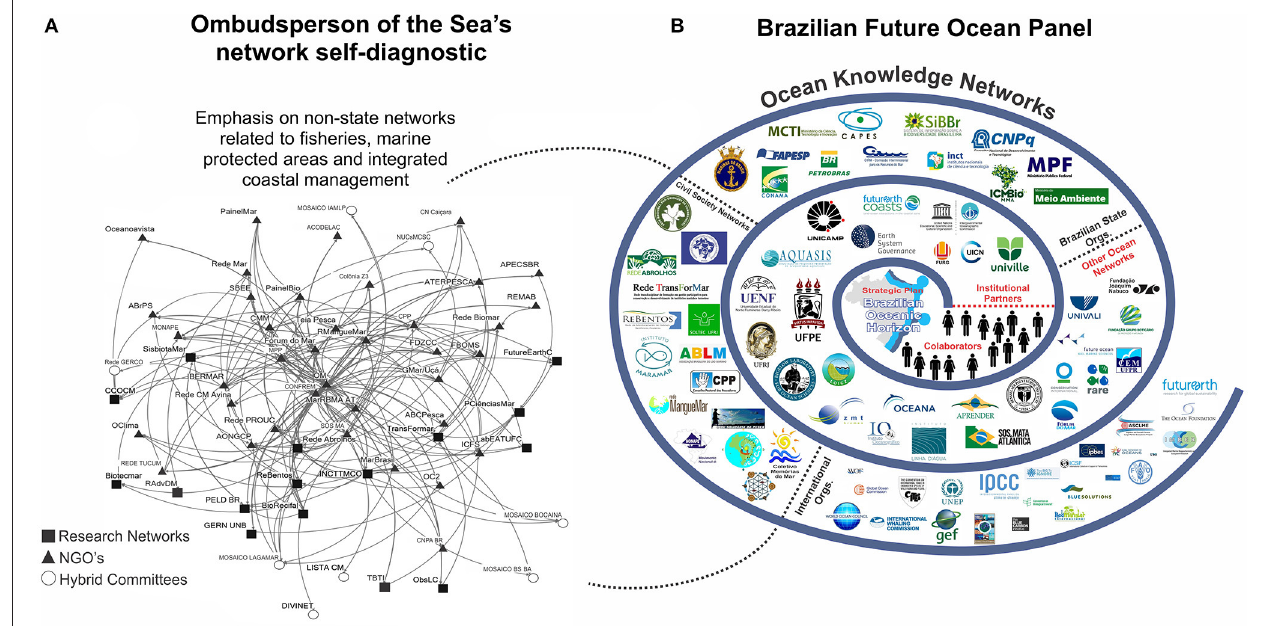
FIGURE 4 | Depiction of the centrality of institutional actors (mostly non-state networks) in the structure of Brazilian ocean problem-domain (A) (Ombudsperson of the Sea self-diagnostic process) and; the structuration of one coastal-marine orchestrator (B) , the Brazilian Future Ocean Panel